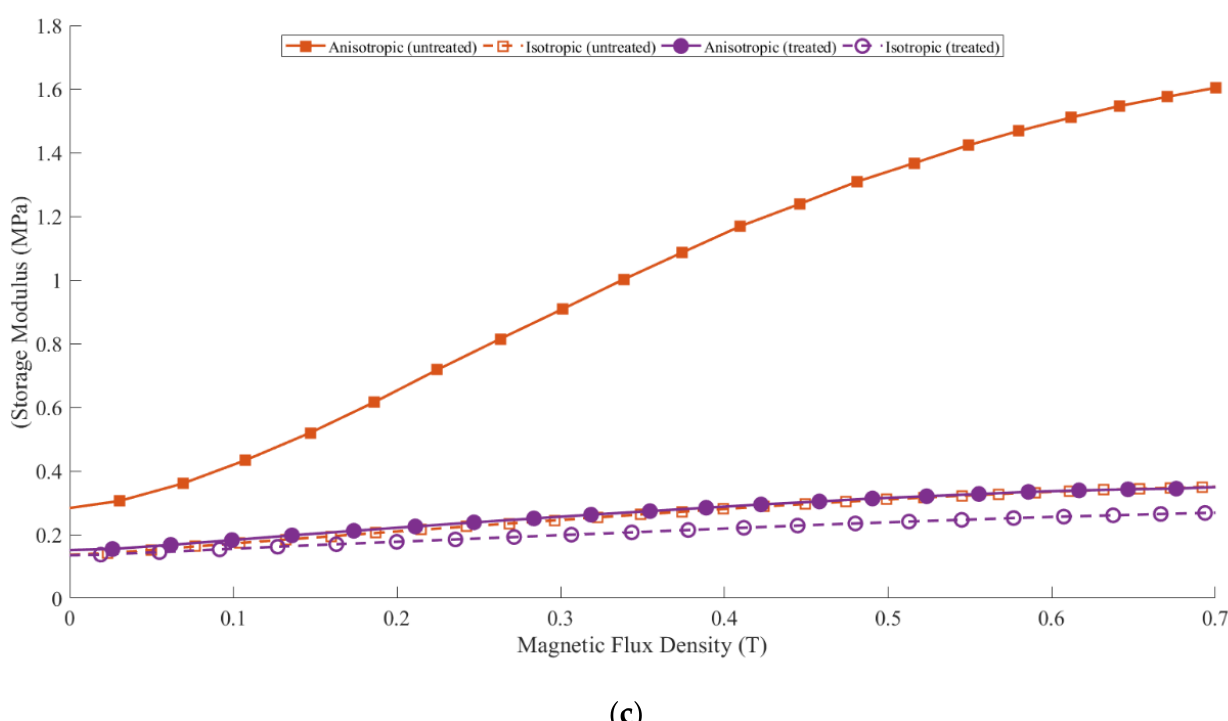
Figure 3. Results of rheometer characterization ( a ) isotropic; ( b ) anisotropic; and ( c ) comparison of anisotropic and isotropic under ramp frequency test.